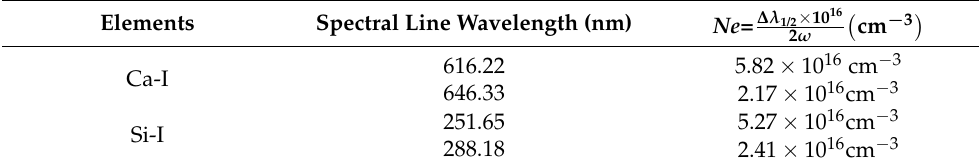
Table 3. List of spectral lines selected for electron number density calculation and calculated values.